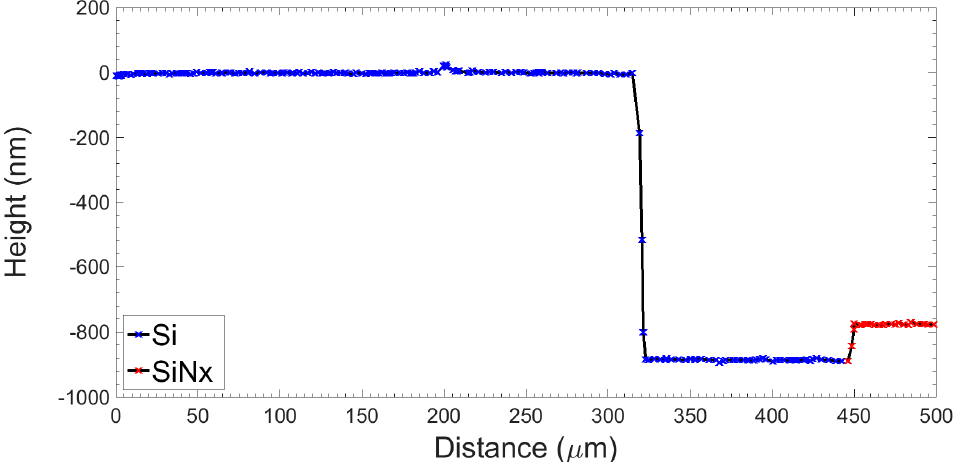
Figure 6. Vertical profile showing a 900 nm silicon channel and a 110 nm silicon nitride (SiN x ) passivation layer prior to electrode deposition and anodic bonding.